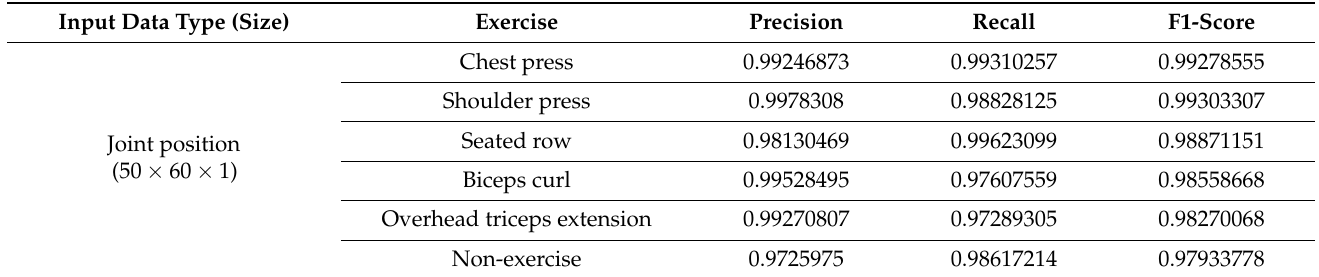
Table 8. Precision, recall, and F1-scores of the joint position input